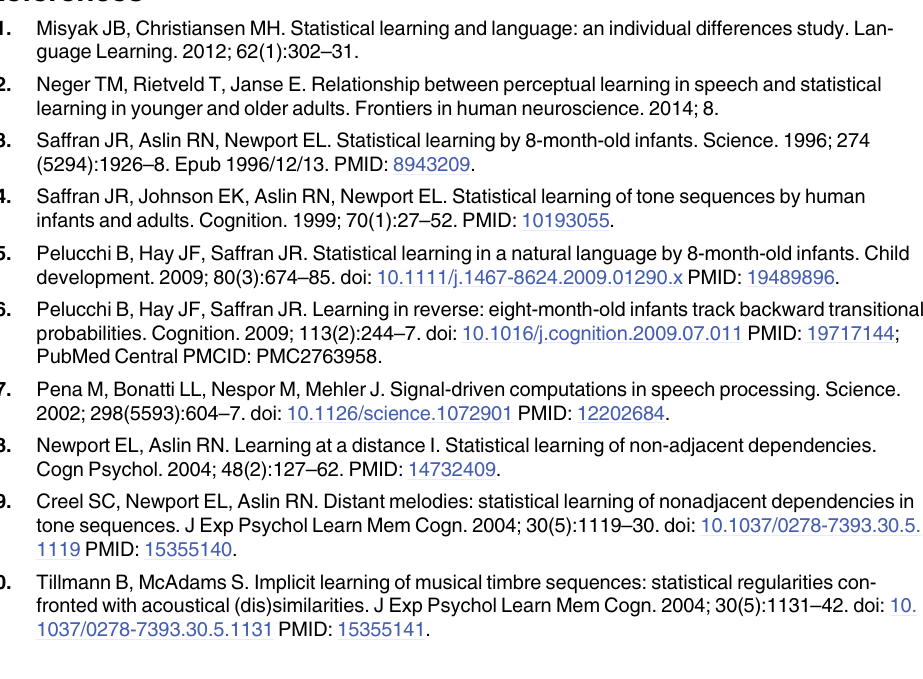
S1 Fig. Cortical thickness results corrected for sex. A. Red: sensitivity to statistics controlled for age and sex. Yellow: sex effects controlled for age and sensitivity to statistics. B. Overlap between sex and statistical